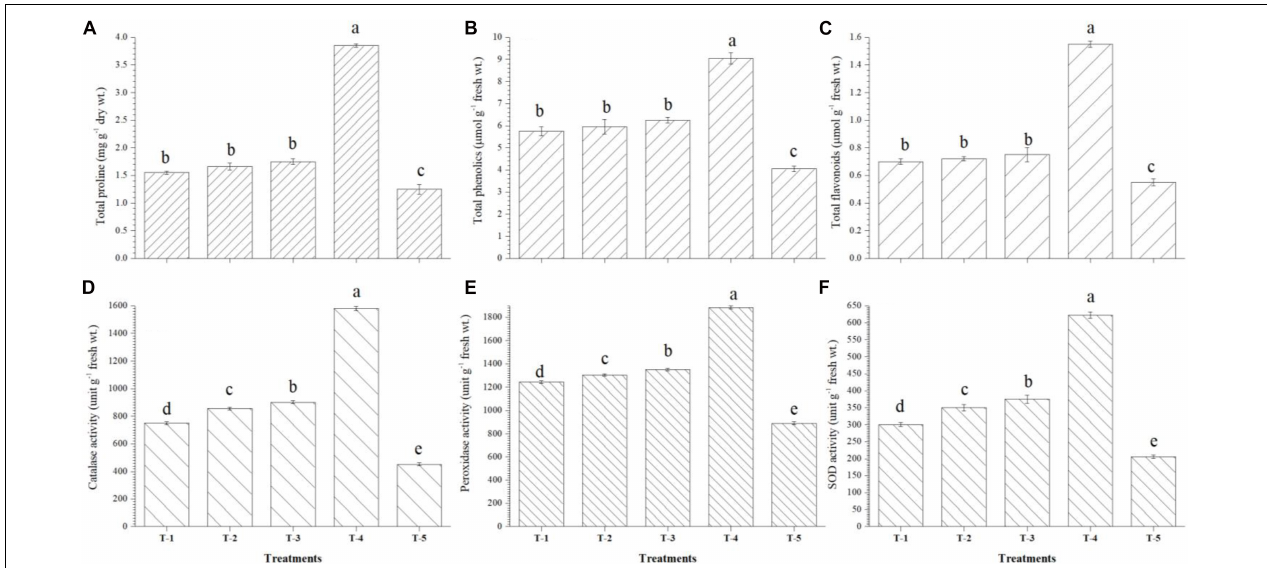
FIGURE 5 | Effects of seed bio-inoculation on activities and accumulation of (A) total proline, (B) total phenolics, (C) total flavonoids, (D) catalase, (E) peroxidase, and (F) SOD in the maize leaves grown in saline sodic soil at 45 days of sowing. Treatments were as follows: T 1 — B. safensis MF-01, T 2 — B. altitudinis MF-15, T 3 — B. velezensis MF-08, T 4 — B. safensis MF-01 + B. velezensis MF-08 + B. altitudinis MF-15, and T 5 —control (untreated). Data are mean ( n = 10) and vertical bar represents standard deviation. Data with different letters show significant difference in column data in randomized block design test at p < 0 . 05 under Duncan’s multiple range